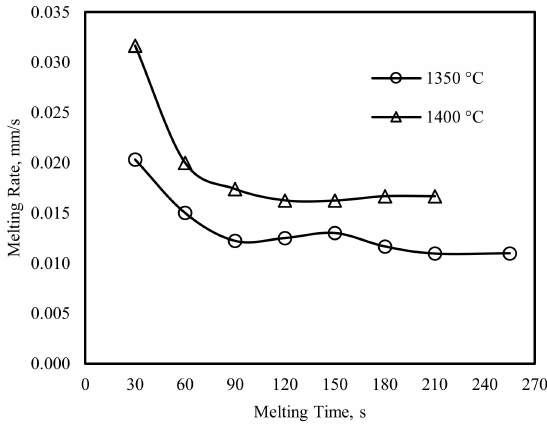
Figure 5. Melting rate of the scrap bar with di ff erent melting times.